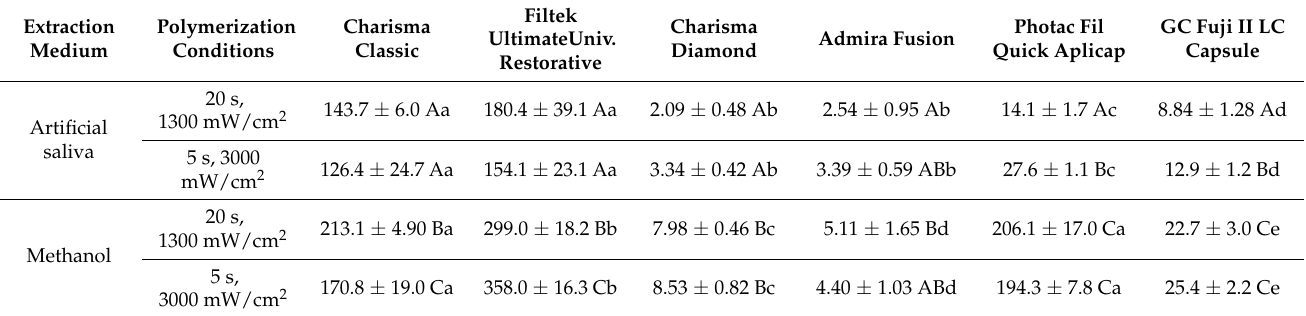
Table 4. Cumulative release of BPA per gram of material (mean ± SD in